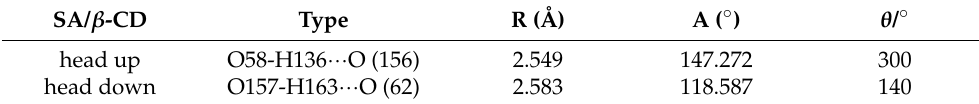
Table 5. Type, bond length (R), and bond angle (A) obtained by ONIOM (B3LYP/6-31G: PM3). SA/ β -CD Type R (Å) A ( ◦ ) θ / ◦ head up O58-H136 ··· O (156) head